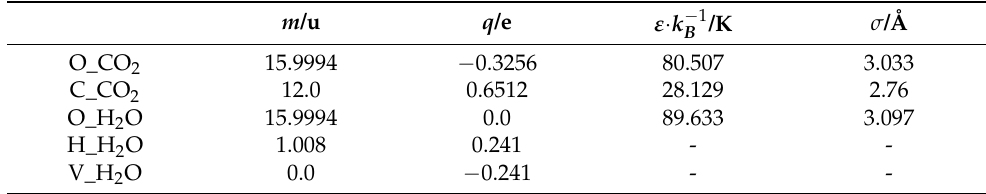
Table 1. Force field parameters of CO 2 [29] and H 2 O [30]